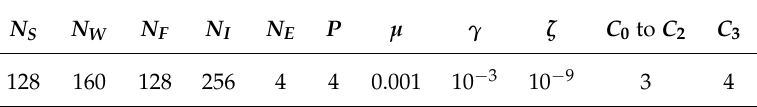
Table 1. Nominal parameters of the control algorithm.